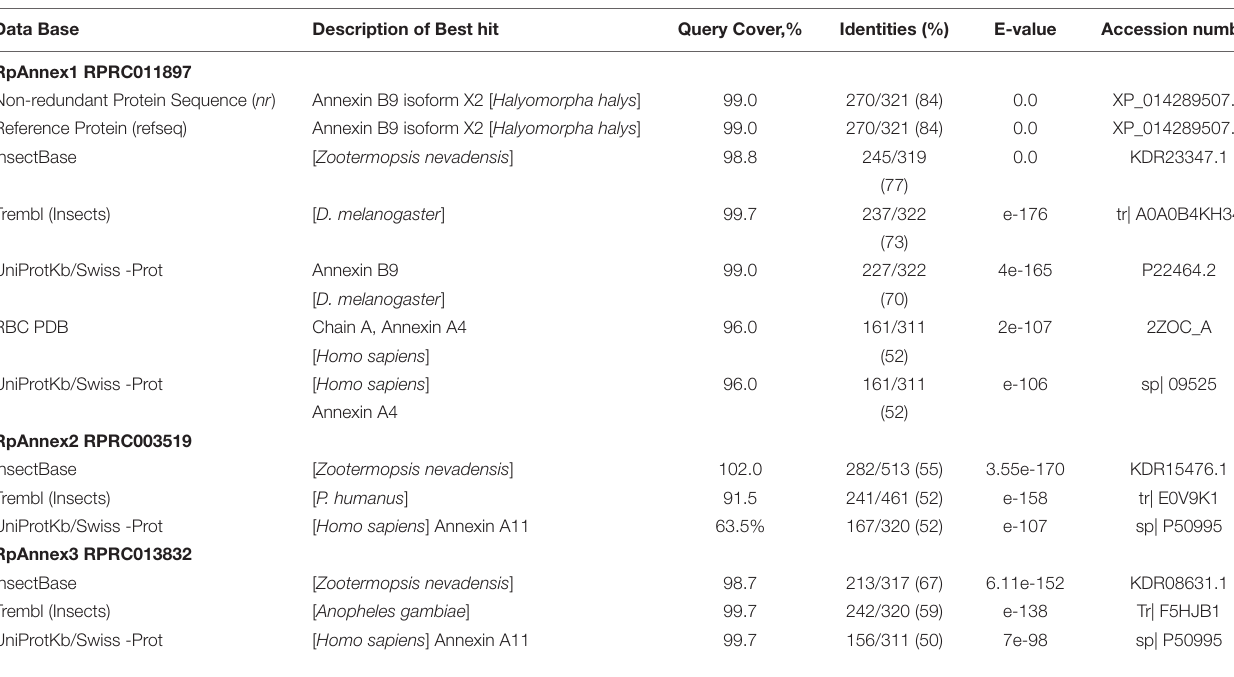
TABLE 4 | Best hits of annexins with different databases using